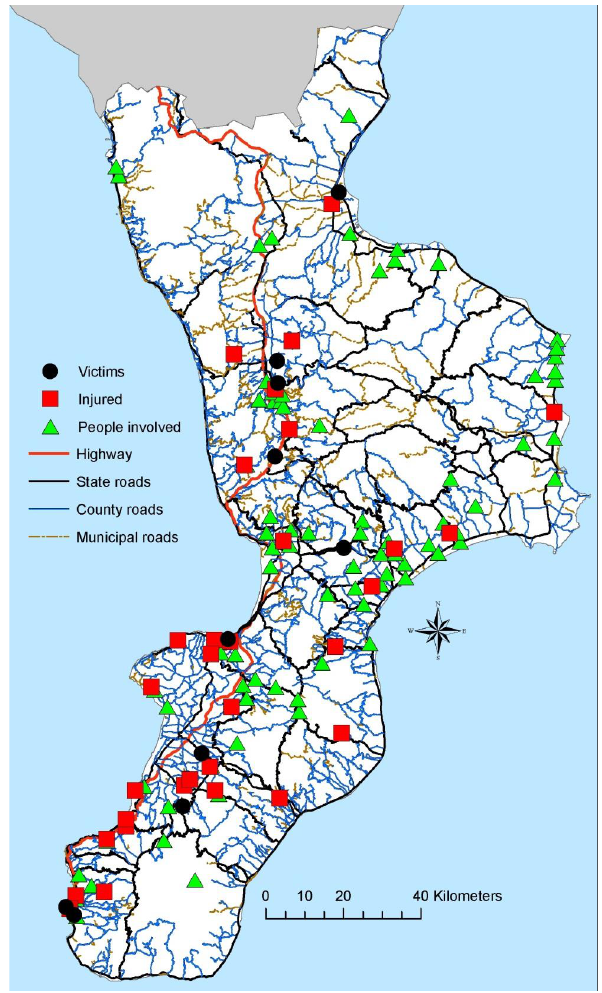
Fig. 3. Localisation of damage to people along the Calabria road network: symbols are explained in the legends.